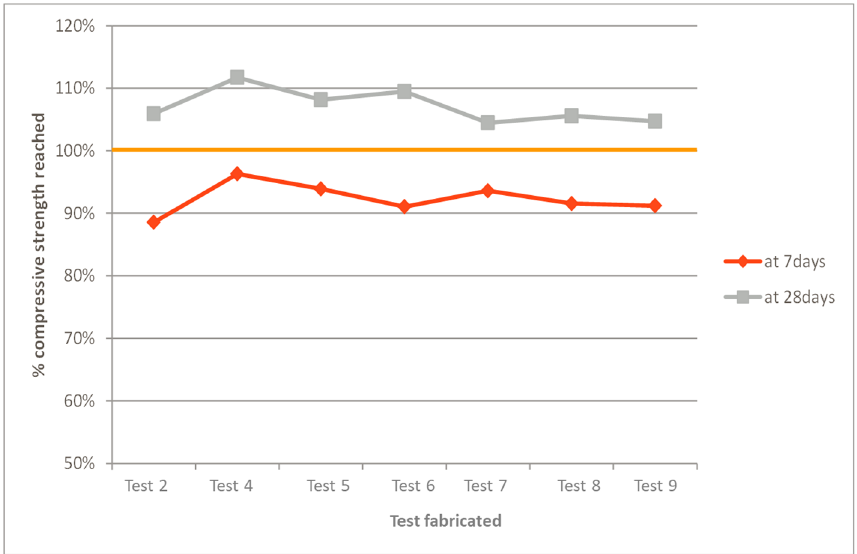
Figure 9. Relative compressive strength of the pilot plant scale high-strength self-compacting con- crete tests. crete tests.